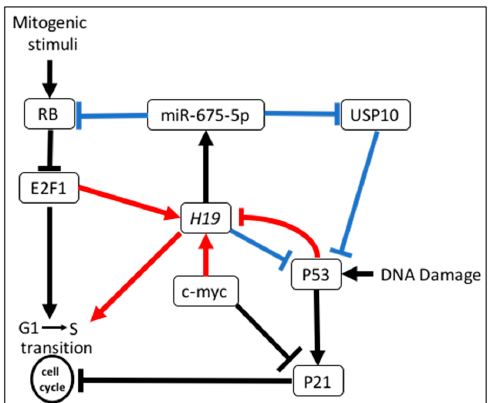
Figure 3. H19 and cell cycle regulation. H19 favors the cell cycle progression through different mechanisms. Mechanisms demonstrated in breast cancer are indicated in red, in other cellular context are indicated in blue. General mechanisms of cell cycle regulation are indicated in black. Arrows indicate positive regulations whereas lines with bars correspond to inhibition.